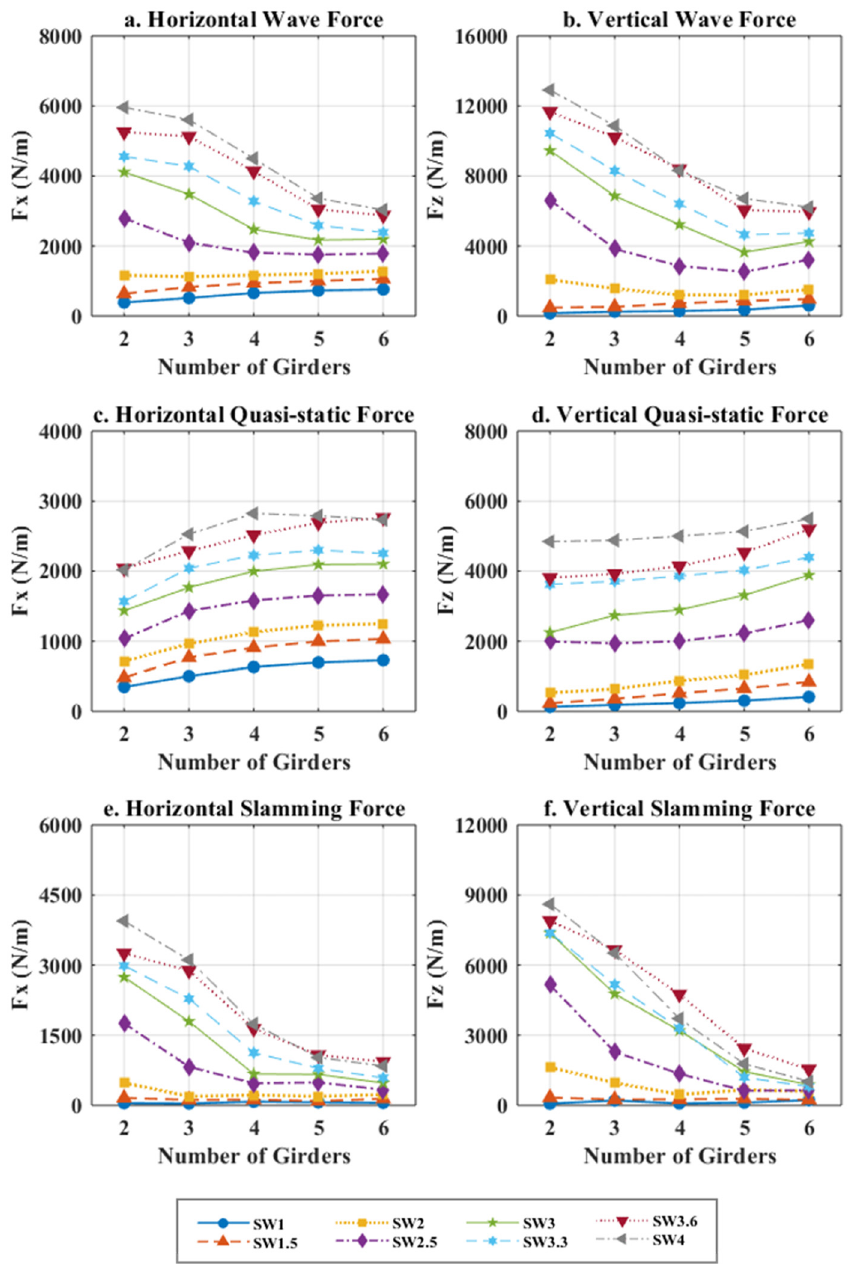
Figure 10. Maximum values of wave forces vs. the number of girders in the deck.